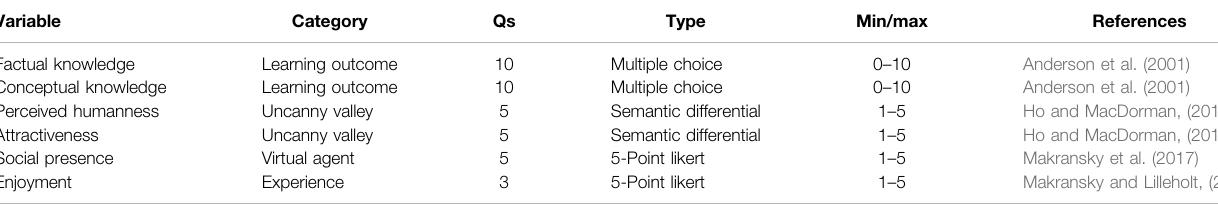
TABLE 1 | Collected survey measures in Study